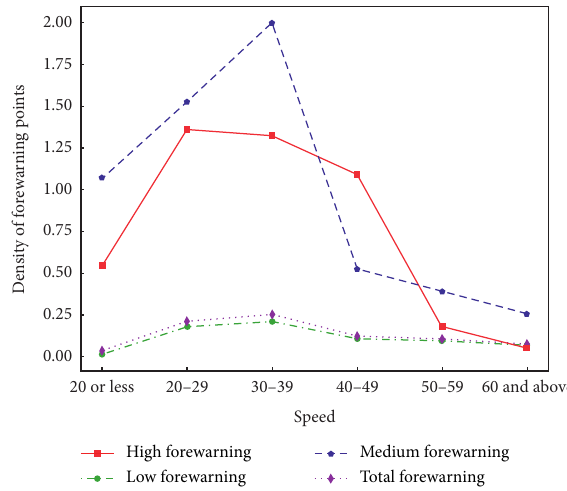
Figure 10: Density of forewarning points corresponding to dif- ferent speeds in each forewarning density